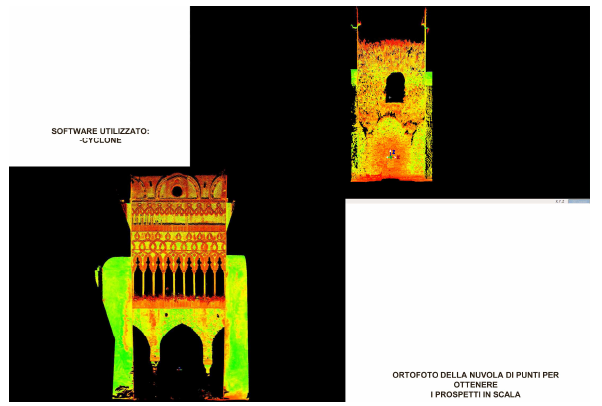
Figure 3. Orthophotos from the point cloud of the cloister Arab partition wall (with reduced small distance between the columns) – and has involved the use of different techniques and of survey, from time to time, appropriate to the needs, constituting a privileged field of experimentation.